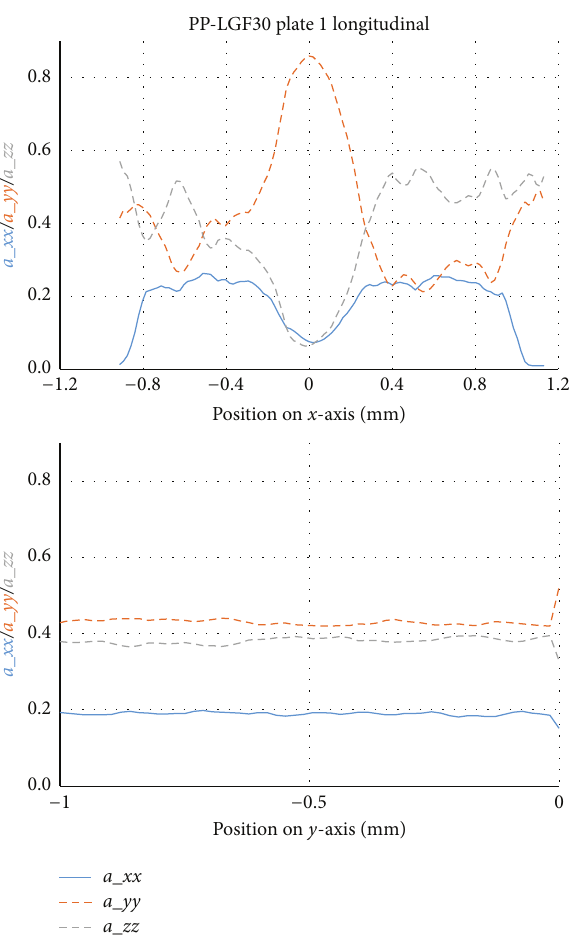
Figure 9: Progress of the fiber orientation along the 𝑥 - and 𝑦 -axis in a plate of PP-LGF30 with initial fiber orientation being longitudinal to the joining direction (hot plate welding). Table 1: Fiber orientation in parts to be joined by hot plate